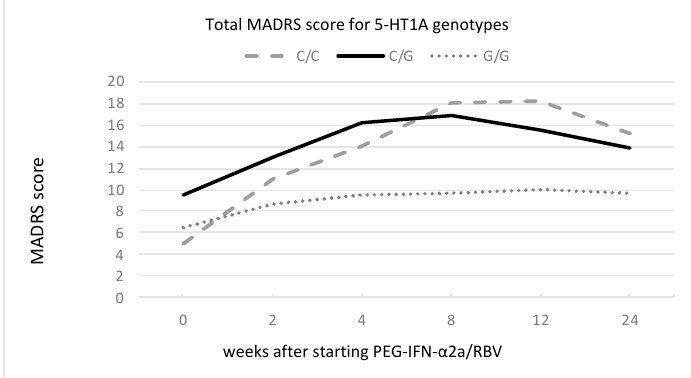
Figure 1. Changes in MADRS score for 5-HT1A genotypes of C/C, C/G, and G/G during PEG-IFN- α 2a/RBV treatment.